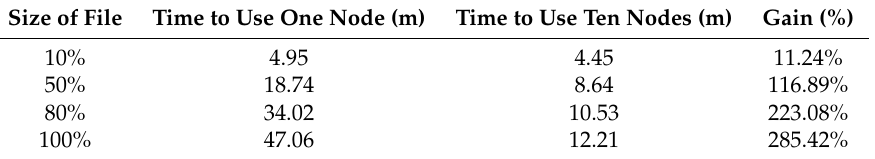
Table 1. Time and gain when implementing our algorithm on different sizes of the